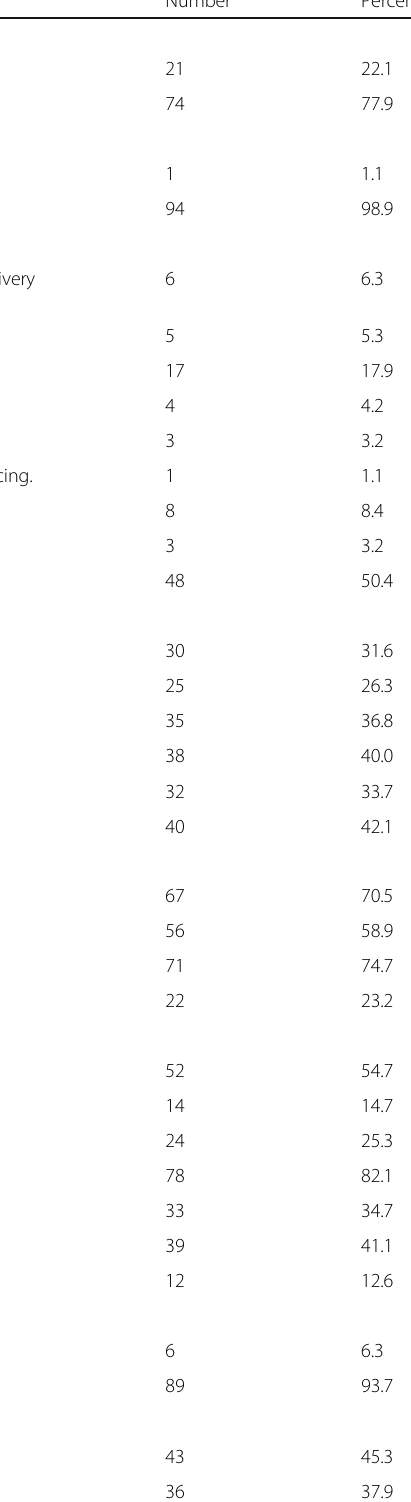
Table 1 Students ’ knowledge about forensic nursing ( N =